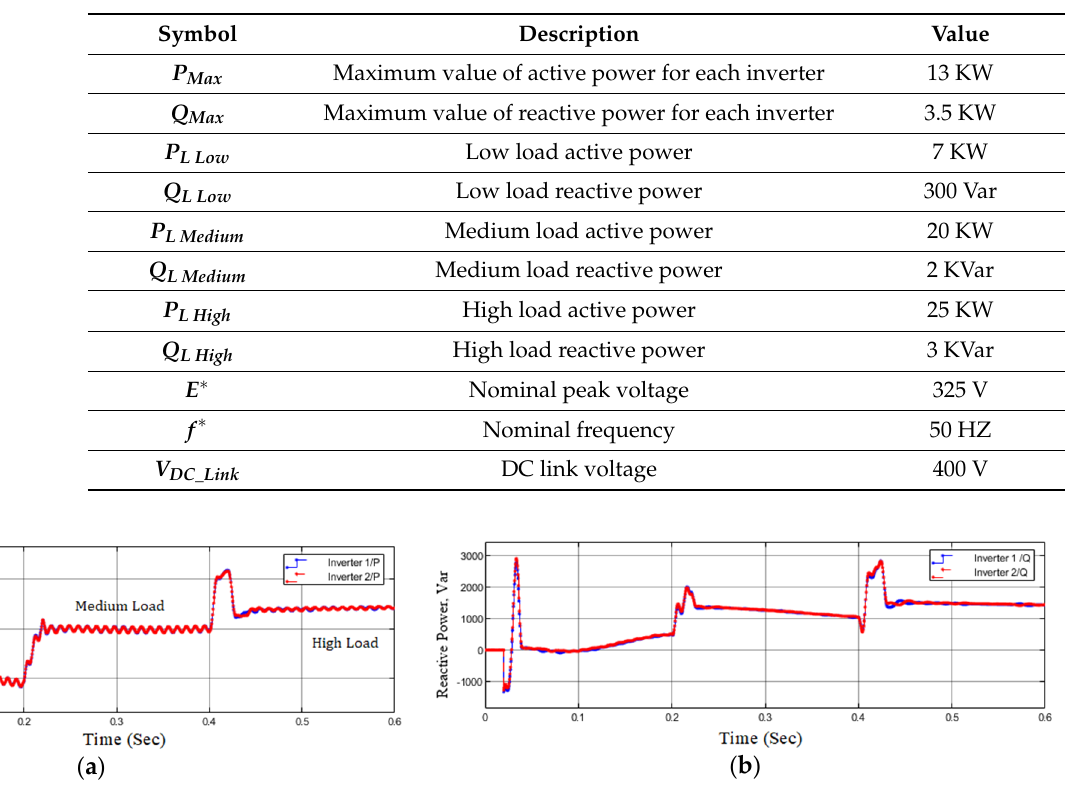
Table 4. Simulation parameters.